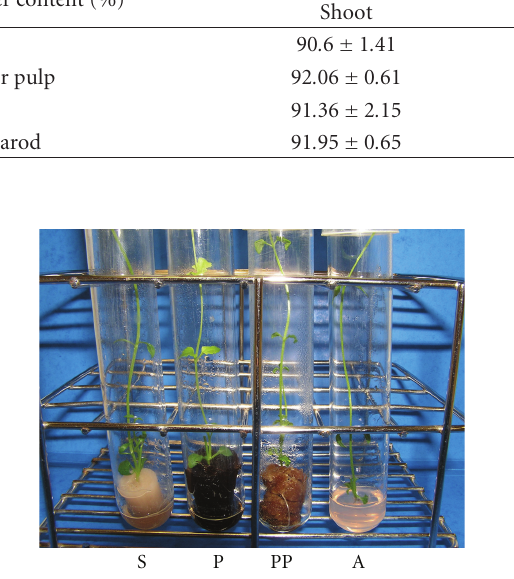
Figure 3: Aspect of nemesia plants on the di ff erent substrates dur- ing in vitro culture phase. S: sorbarod; P: peat; PP: paper pulp; A: